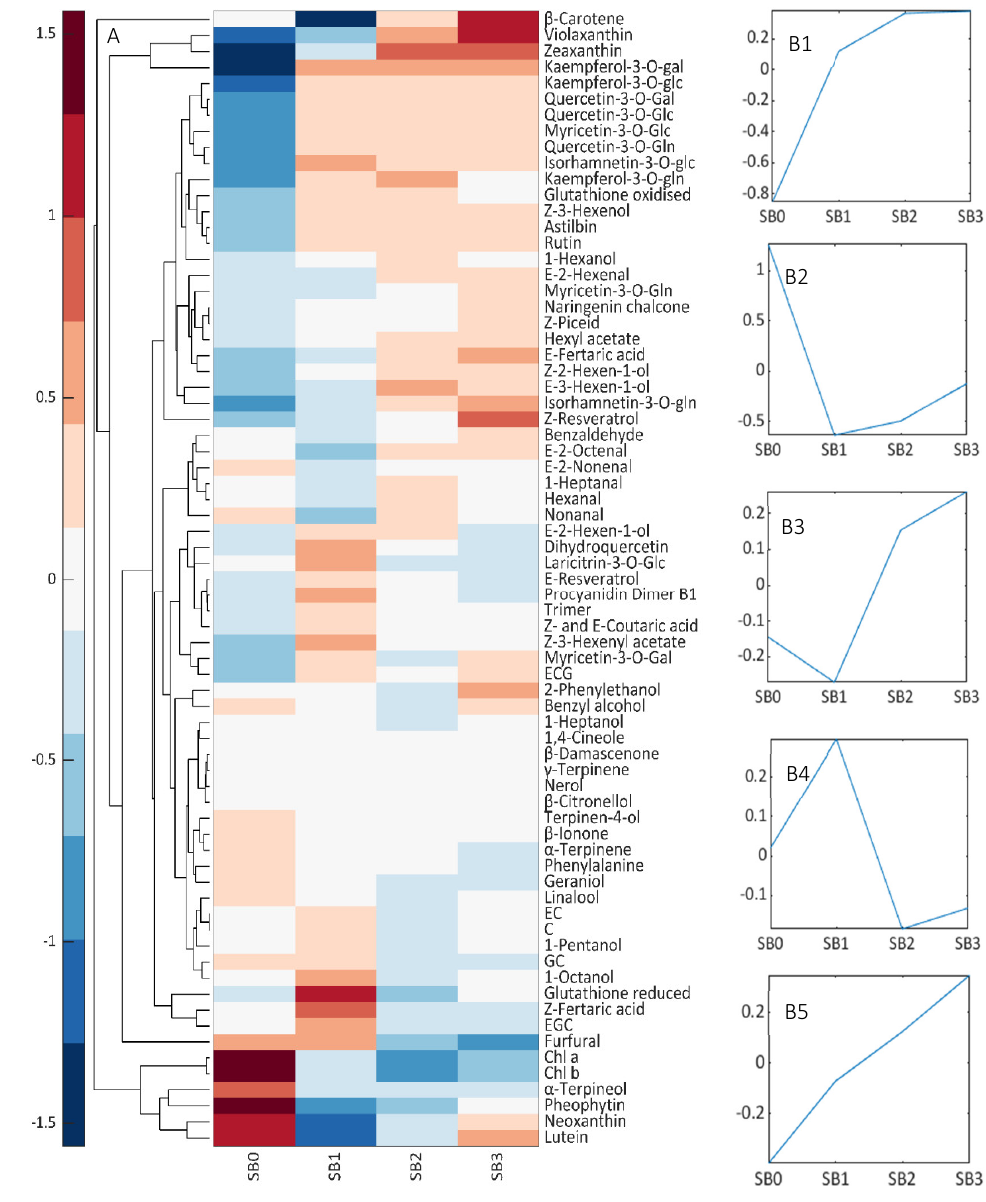
Figure 6. Impact of sunburn browning damage on carotenoid, polyphenol and free volatile compound concentration. ( A ) The heatmap represents metabolite concentrations at each damage level (SB0–SB3). Cell colours indicate relative concentrations for each SB level, with blue corresponding to the minimum and red to the maximum values. ( B1 – B5 ) Metabolite evolution pattern according to damage level. Variables in each group are listed in Supplementary Table S5. ECG, (−)-Epicatechin gallate; EC, (−)-Epicatechin; C, (+)-Catechin; GC, (+)-Gallocatechin; EGC, (−)-Epigallocatechin.